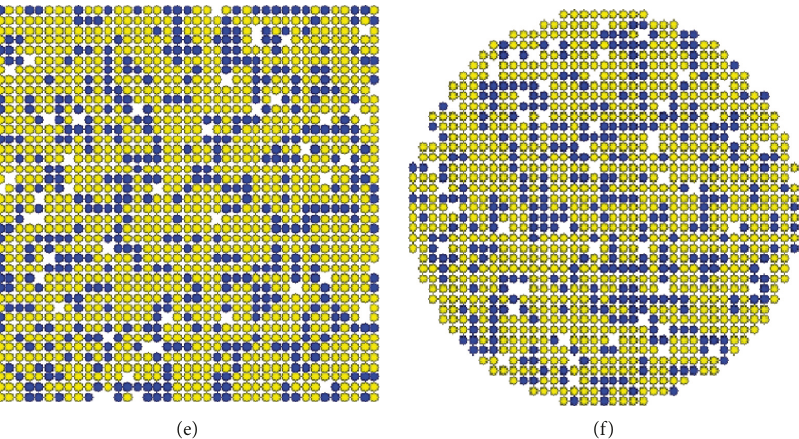
Figure 9: Structure of numerical model. (a) Entire model of AC-13. (b) Vertical section view of AC-13. (c) Transverse section view of AC-13. (d) Entire model of SMA-13. (e) Vertical section view of SMA-13. (f) Transverse section view of SMA-13.